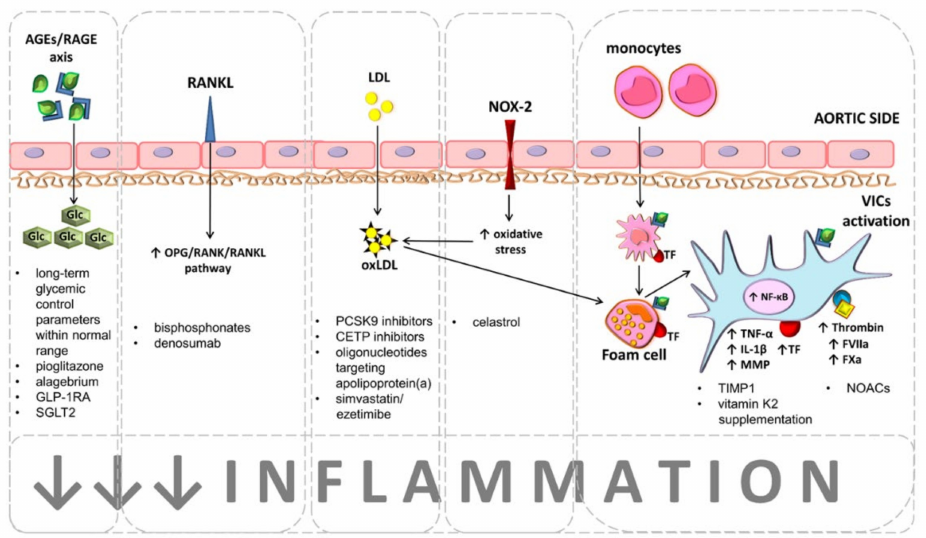
Figure 1. Potential therapeutic targets to retard calcific aortic stenosis (CAS) development or